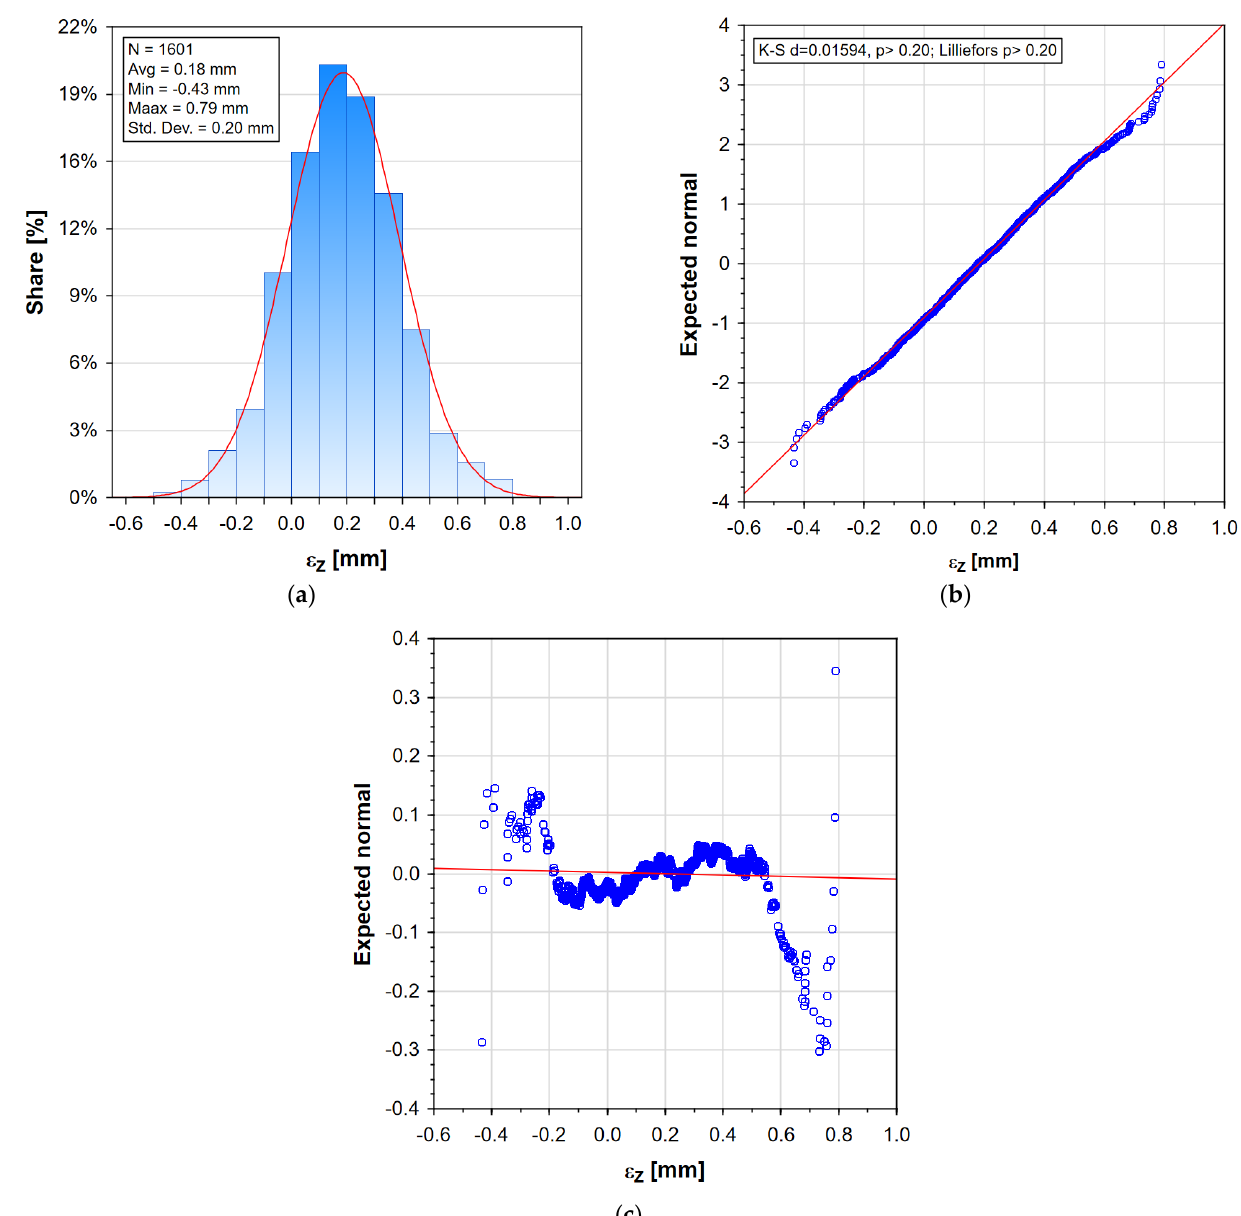
Figure 16. Coordinate deviation of measurement points in the direction of Z B axis for measurement series 4: ( a ) distribution histogram, ( b ) normality diagram, and ( c ) normality deviation diagram. Table 6. Summary of the basic statistics of deviations in the direction of Z B axis of all measurement points registered in individual measurement series.